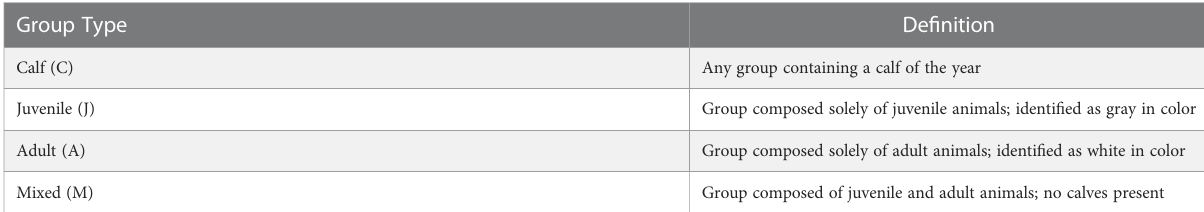
TABLE 1 Classi fi cation of beluga groups by age